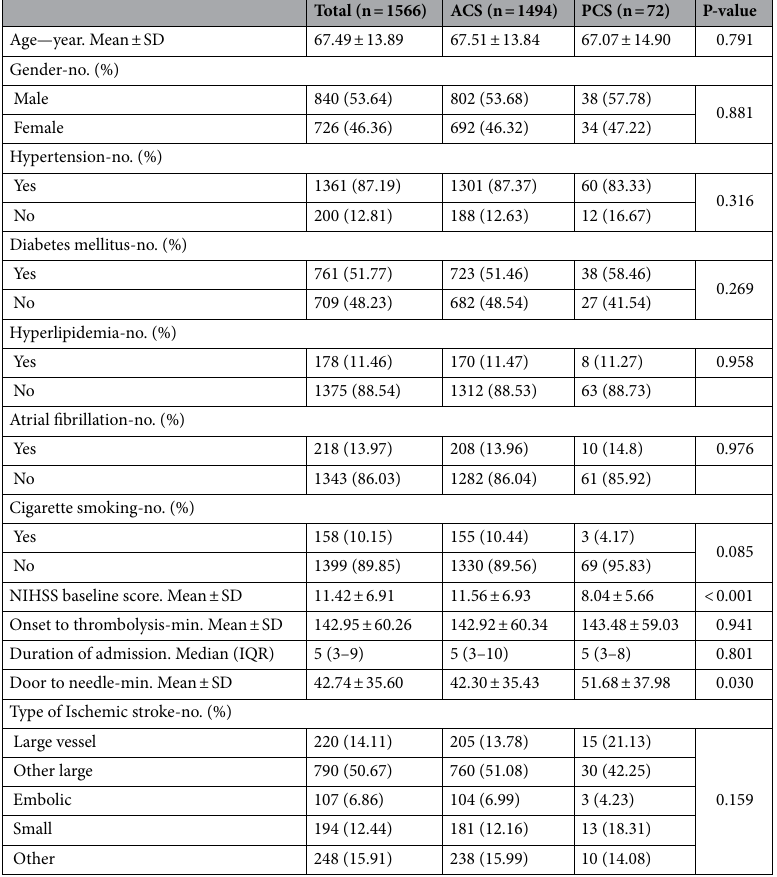
independence, and local hemorrhage in univariate analysis were evaluated; further, the cases with these outcomes were compared with those without these outcomes (Table 3). The odds of various outcomes were assessed for ten factors, including circulation, age, gender, cigarette smok- ing, AF, diabetes, hypertension, NIHSS score, admission duration, and stroke type. According to the results, all of these factors, except vascular territory, gender, and cigarette smoking, were significantly associated with 3-month mortality, excellent outcome, and functional independence in the univariate analysis. Three‑month mortality outcome. Based on the multivariate logistic regression analysis with selection adjusted for covariates, the three-month mortality was significantly related to age ≥ 70 (OR 2.26, 95% CI 1.59– 3.23), AF (OR 1.99, 95% CI 1.24–3.17), diabetes (OR 1.49, 95% CI 1.06–2.08), high NIHSS score (6–14, OR 3.30, 95% CI 1.56–6.95, NIHSS score 15–24, OR 10.80, 95% CI 5.09–22.94, NIHSS score > 24, OR 14.27, 95% CI 5.56–36.60 compared with subjects with NIHSS score ≤ 5), admission duration (OR 1.02, 95% CI 1.00–1.04), stroke type (other large vessels, OR 0.58, 95% CI 0.37–0.90 and embolic, OR 0.22, 95% CI 0.09–0.51 compared to subjects with the large vessel) (see Table 3). Three‑month excellent outcome. According to the related results, the excellent outcome was signifi- cantly related to age ≥ 70 (OR 2.22, 95% CI 1.69–2.91), diabetes (OR 1.58, 95% CI 1.21–2.07), high NIHSS score (6–14, OR 2.03, 95% CI 1.38–2.99, NIHSS score 15–24, OR 6.16, 95% CI 4.00–9.49, NIHSS score > 24, OR 8.35, 95% CI 3.74–18.65 compared with subjects with NIHSS score ≤ 5) and admission duration (OR 1.06, 95% CI 1.04–1.08) (see Table 3). Three‑month functional independence. The related results showed that functional independence (three-month) was significantly associated with age ≥ 70 (OR 2.56, 95% CI 1.92–3.411), diabetes (OR 1.51, 95% CI 1.14–2.01), high NIHSS score (6–14, OR 1.92, 95% CI 1.24–2.96, NIHSS score 15–24, OR 6.50, 95% CI 4.07–10.0.37, NIHSS score > 24, OR 10.04, 95% CI 4.42–22.81 compared with subjects with NIHSS score ≤ 5) and admission duration (OR 1.07, 95% CI 1.05–1.09) (see Table 3).